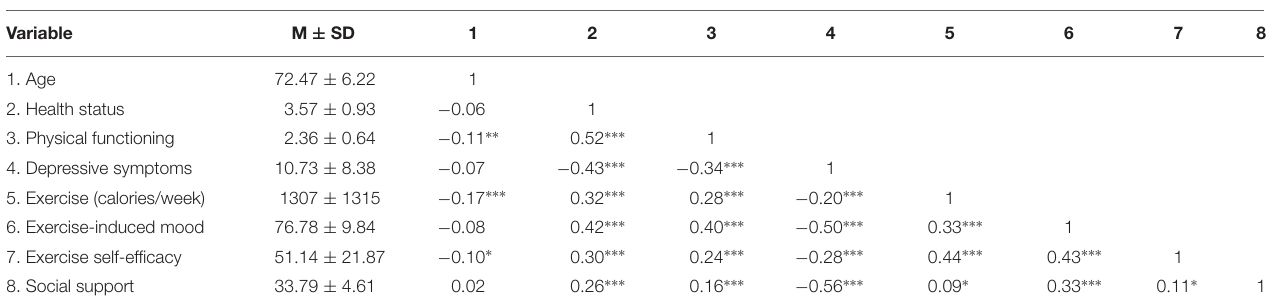
TABLE 2 | Means, standard deviations, and intercorrelations among study variables.